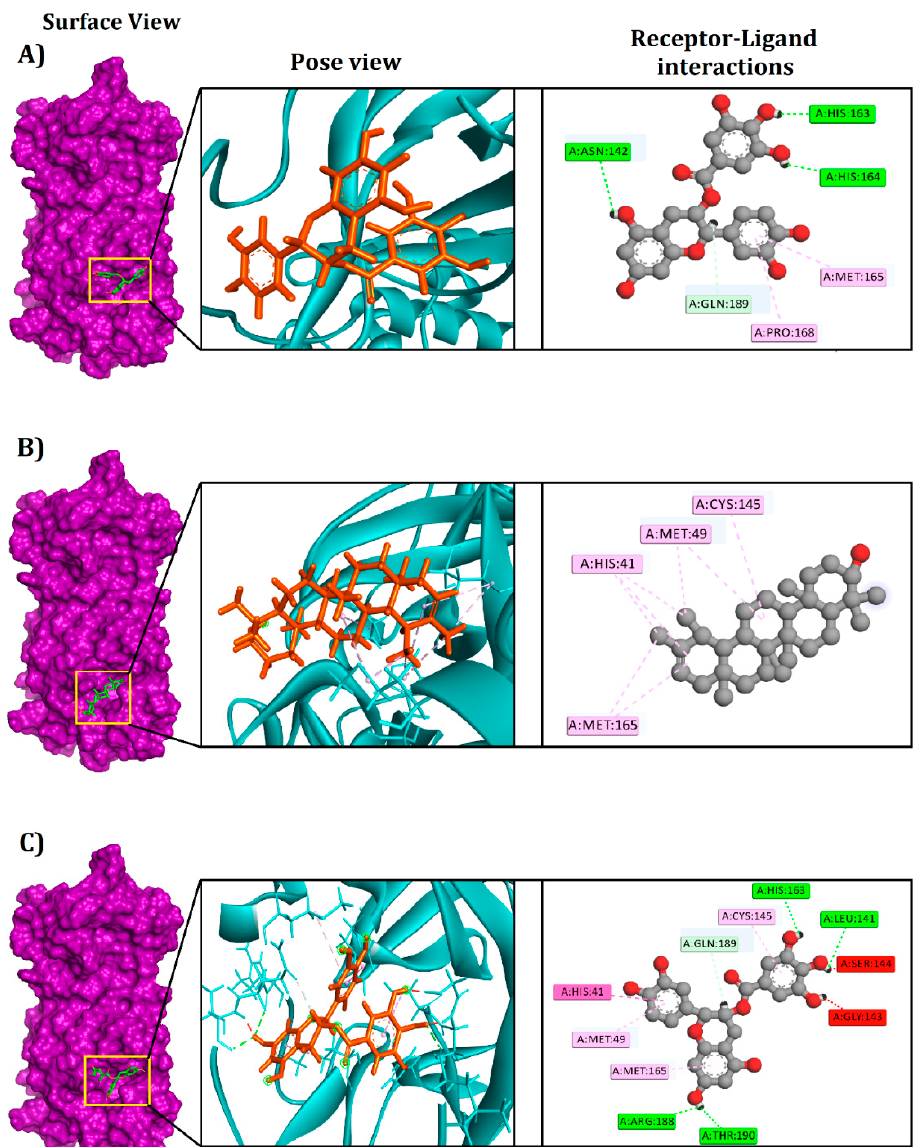
Figure 2. The various binding modes for the selected compounds within the active and catalytic sites of the SARS-CoV-2 main protease. ( A ) epicatechin-3-O-gallate, ( B ) psi-taraxasterol, and ( C ) catechin gallate.